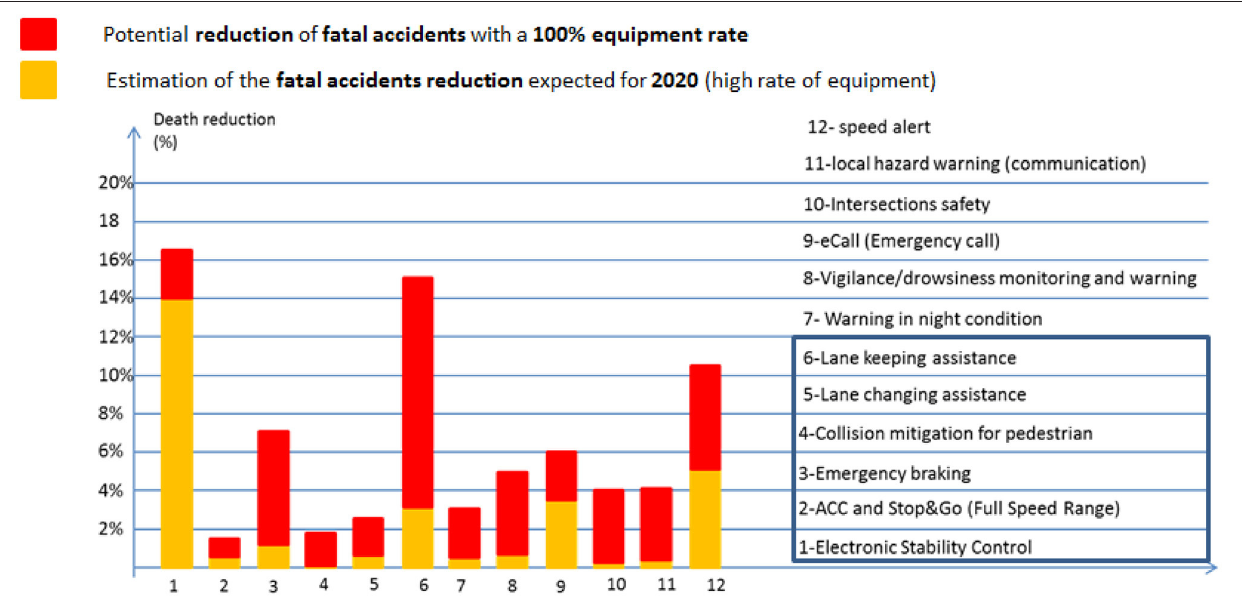
Frontiers in Sustainable Cities |